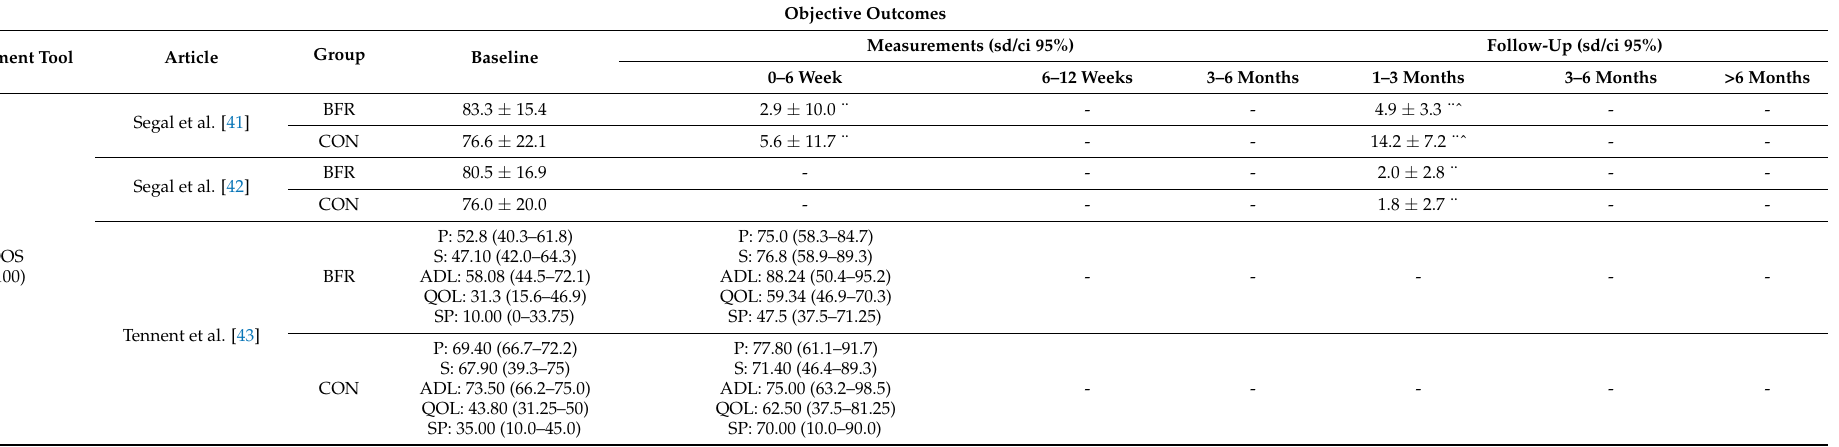
Table 5. Pain analyzed in the short-, medium-, and long-term, both during the intervention period and in a follow-up that could be longer than 6 months after the end of the